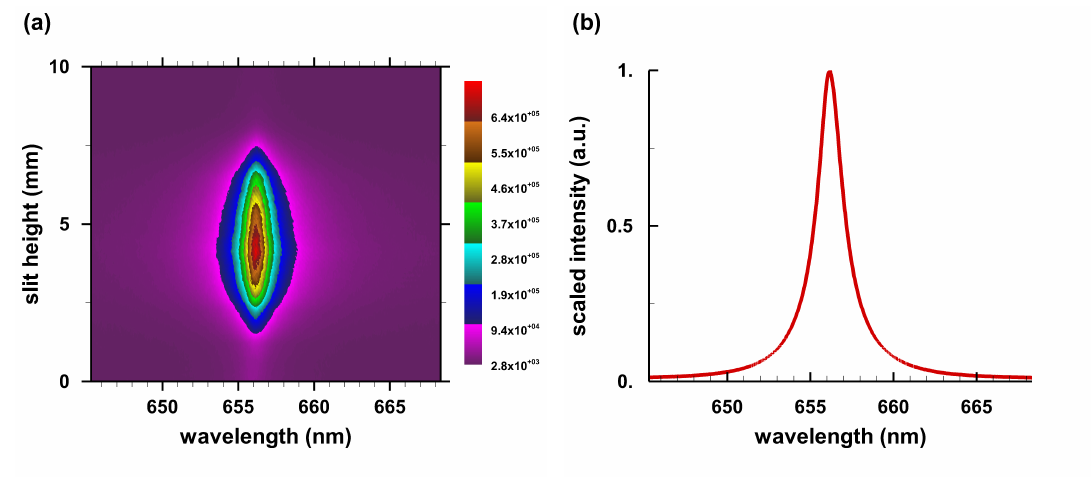
Figure A2. H α spectra for τ = 250 ns: ( a ) H α map; and ( b ) scaled